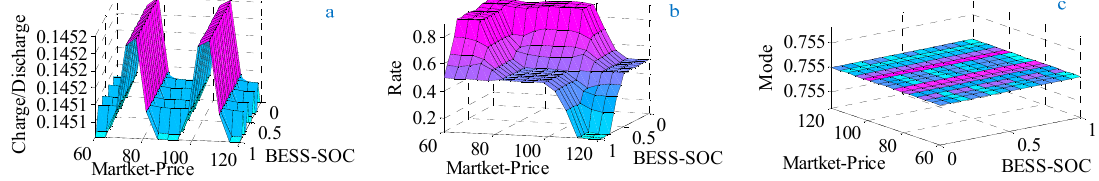
Figure 9. Control surfaces for BESS operation controller corresponding to market price and BESS SOC: ( a ) charging/discharging mode; ( b ) charging/discharging rate; ( c ) BESS operation mode.